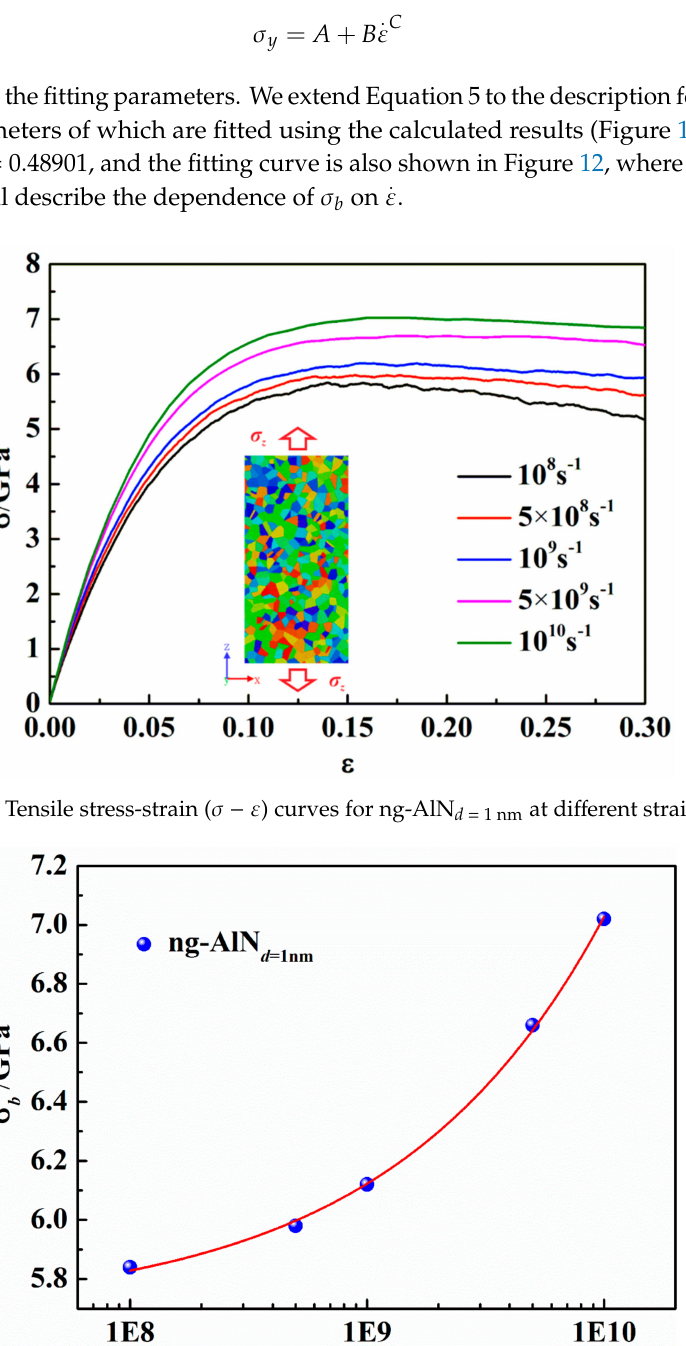
Figure 12. Ultimate strength as a function of strain rate (